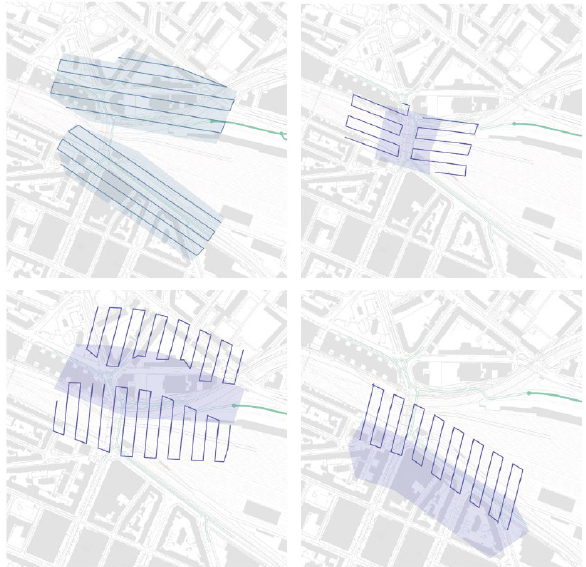
Figure 9. UAV flight missions. The lines describe the path, and the coloured surface is the photographed area. In the top left image: UAV flight with nadir view, the remaining images: UAV flight with oblique view (45°).